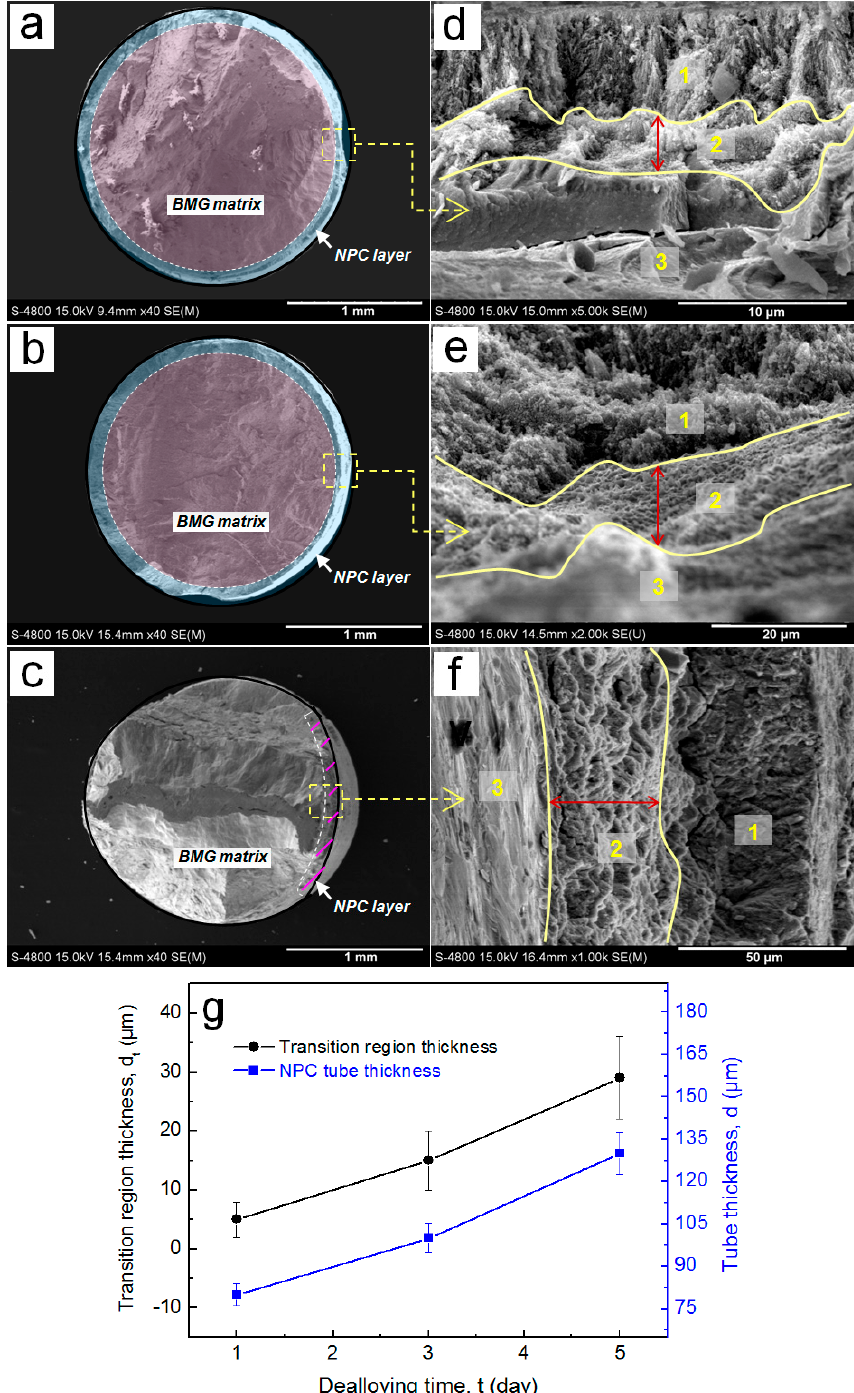
Figure 7. SEM images showing the fracture morphologies of the NPC/BMG composite rods subjected to the compression testing: ( a – c ) The cross-sectional morphology of the NPC/BMG rod 1, rod 2, and rod 3, respectively; ( d – f ) Corresponding high magnification images of a–c (the arrows show the observation position), all fractured composite rods exhibiting three distinct characteristics from the glassy matrix to NPC; ( g ) Changes in the NPC tube thickness and transition region width with dealloying time.